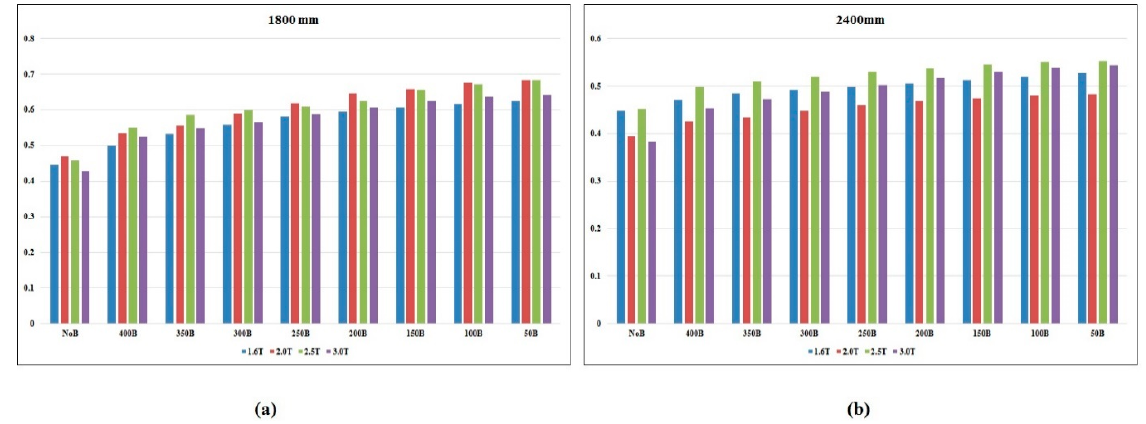
Figure 17. Ultimate load capacities based on thickness and reinforcement spacing for ( a ) 1800 mm models and ( b ) 2400 mm models.